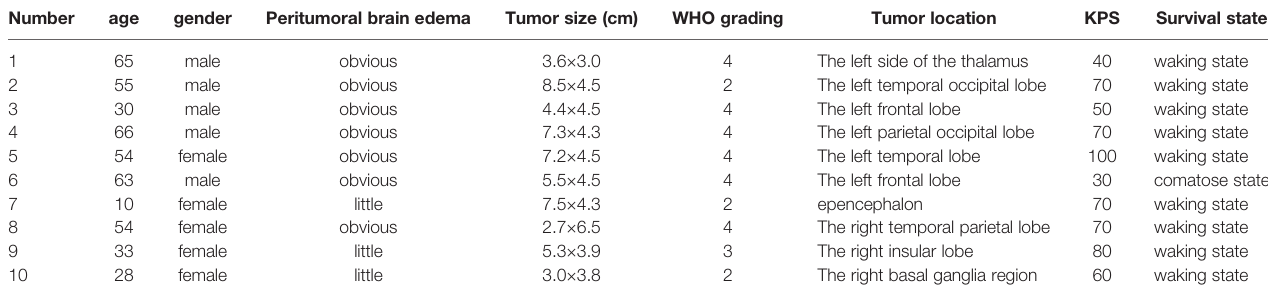
TABLE 3 | Clinical characteristics of patients enrolled for